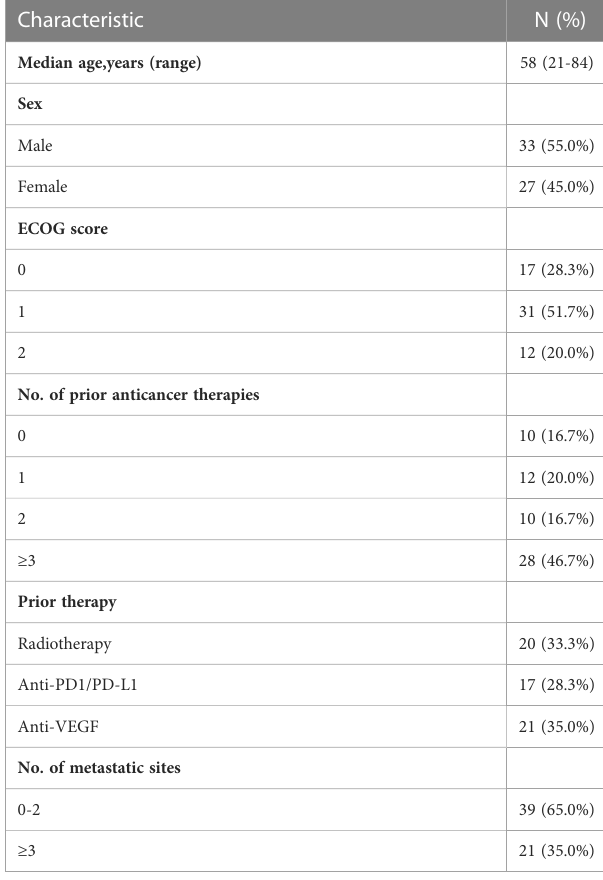
TABLE 1 Patient baseline demographics and disease characteristics.